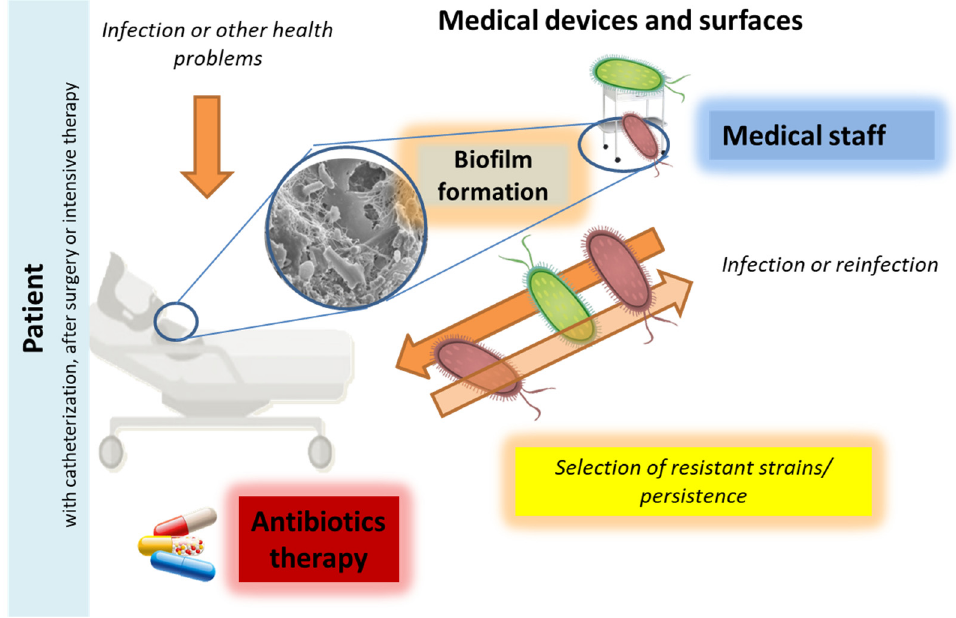
Figure 1. The simplified cycle of nosocomial bacterial infection and the crucial role of biofilms in the spreading and resistance process. The biofilms formed may be related to bacterial resistance depending on environmental conditions, in particular cleaning procedures, disinfection, and antibacterial agents. Increased persistence and avoidance of treatment with antibacterial substances lead to the preservation of bacteria on medical devices, surfaces, and tissues. This increases the risk of reinfection, contributes to the selection of resistant strains and their spread in the hospitals.